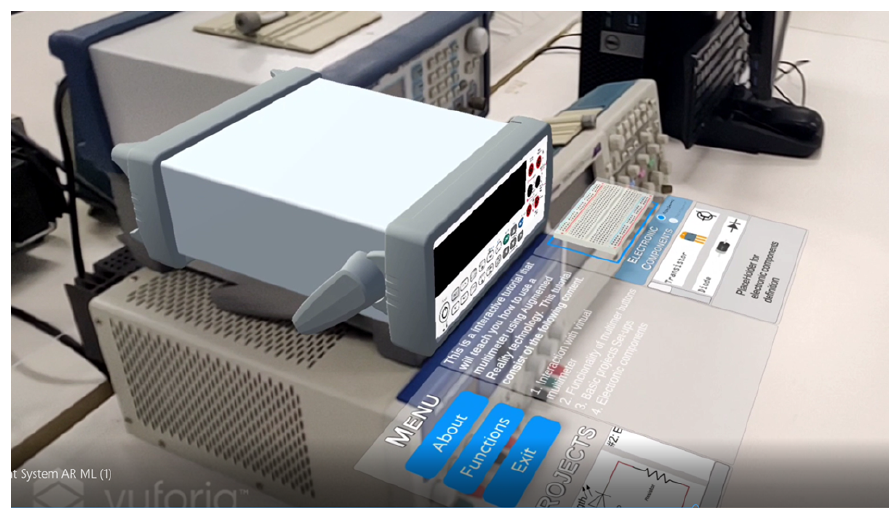
Figure 9. AR training scenario: object tracking and superimposition of a 3D